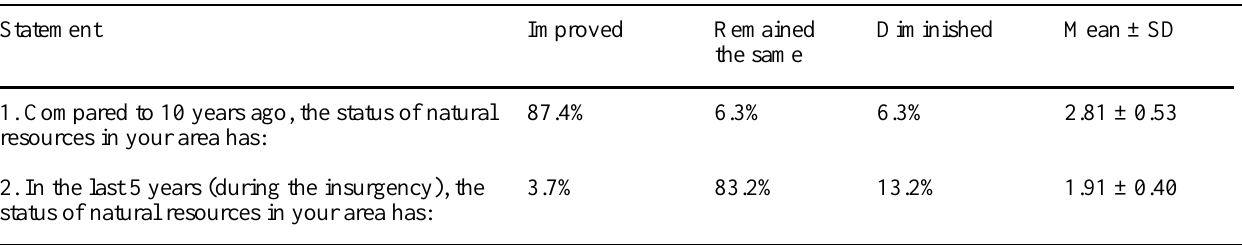
Table 5 . Perceptions of Conservation Area Management Committee members regarding the status of natural resources within the Annapurna Conservation Area over two time periods, measured on a 3-point scale: improved = 3, remained the same = 2, diminished = 1. (Source: authors’ interview data; n =